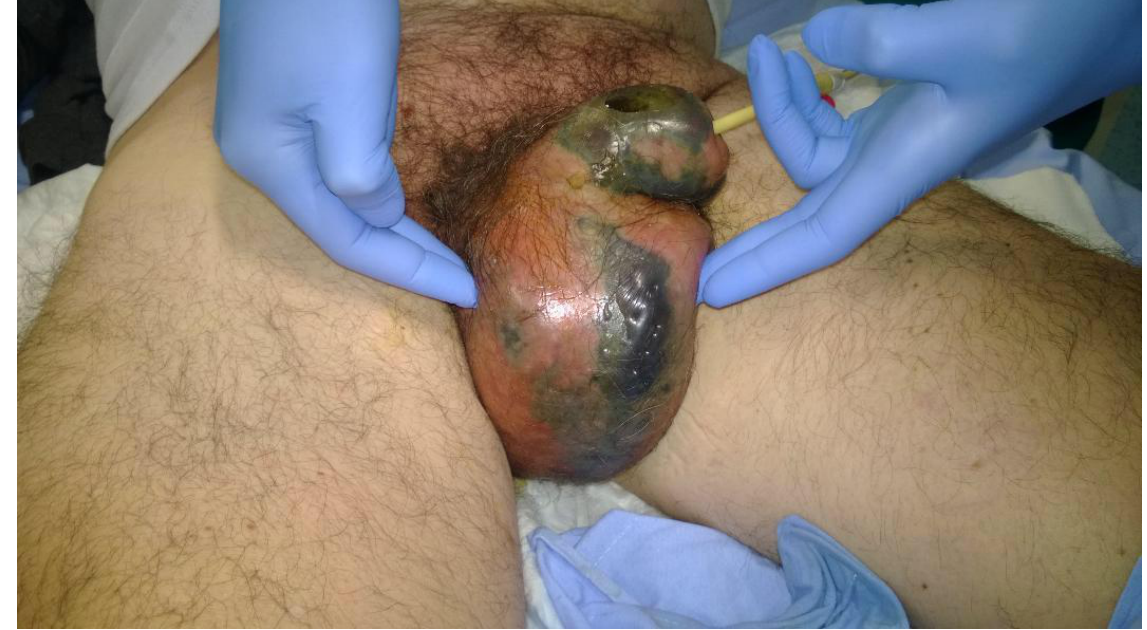
Figure 1: The physical examination was notable for necrotic-appearing tissue in the entire penis and scrotum, with areas of induration and